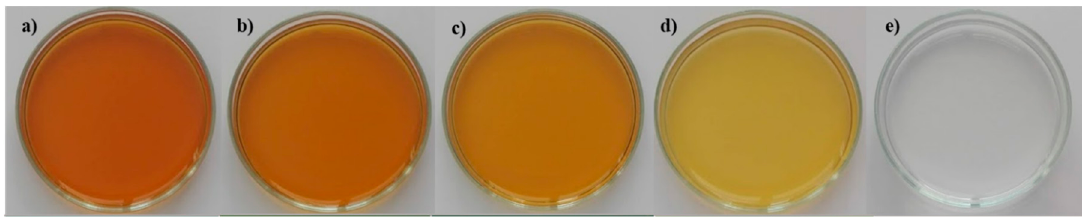
Figure 2. Carob liqueurs obtained by different extraction methods: hydro-alcoholic infusion ( a ), maceration ( b ), percolation ( c ), aqueous infusion ( d ) and distillation ( e ).